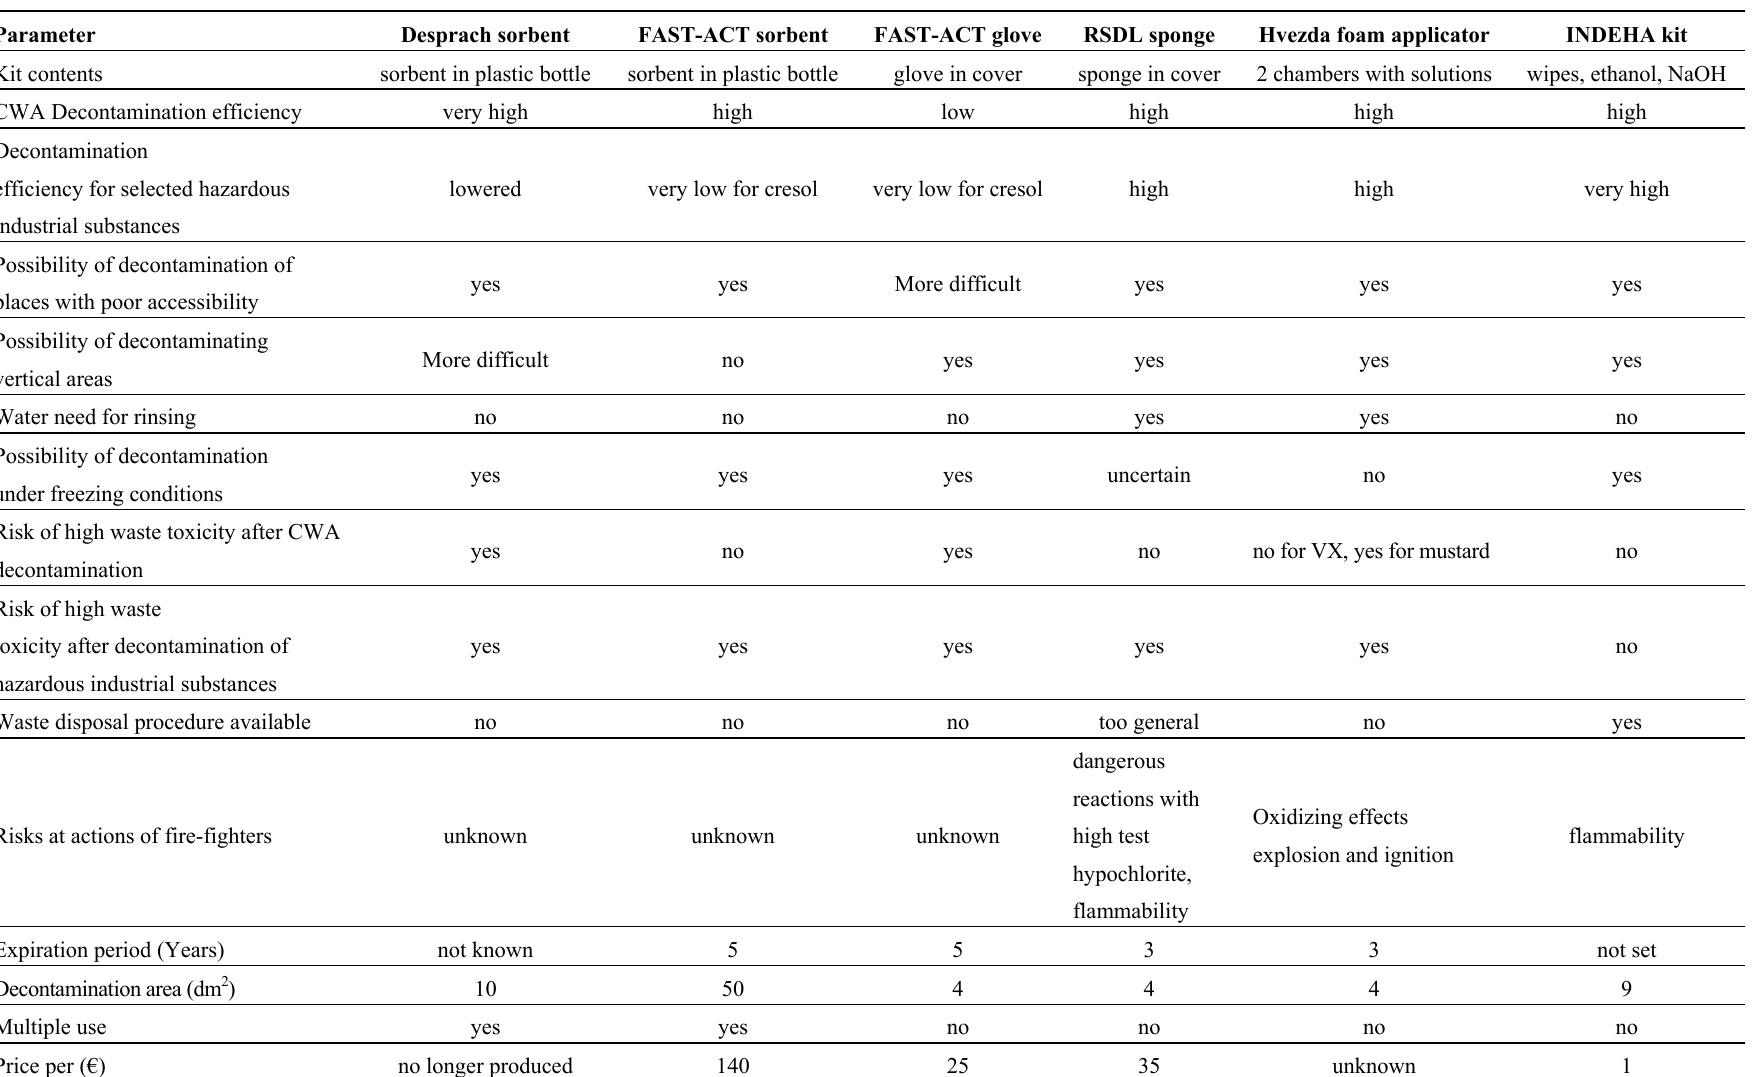
Table 5. Overall evaluation of decontamination